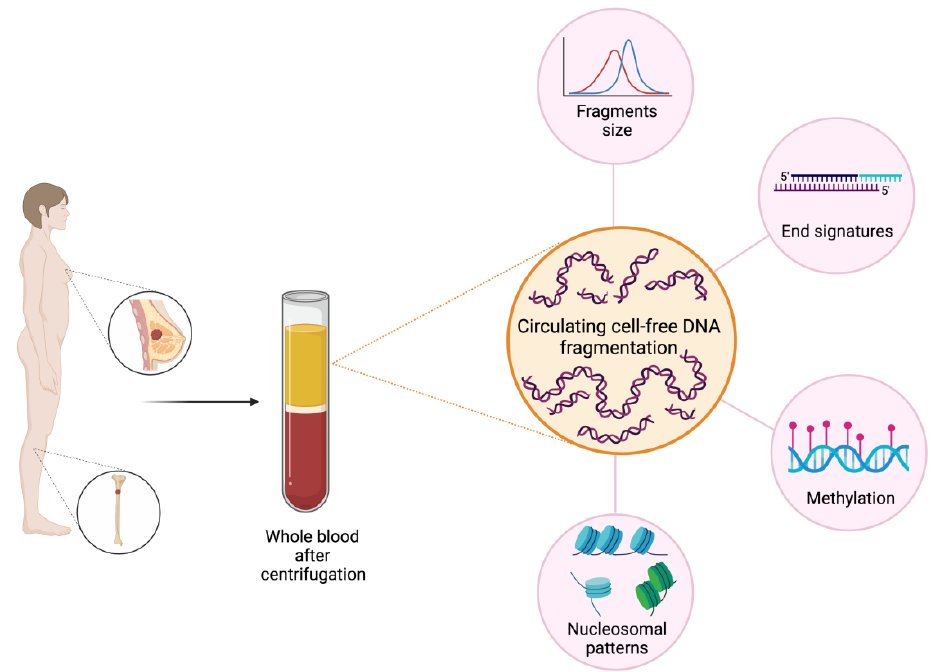
Figure 1. Fragmentomics features in BC. The study of fragmentomics in BC includes various aspects such as the evaluation of fragment size and cfDI, the study of fragment ends with specific motifs included in the sequence of the fragment and the nucleosome footprints or position. The potentiality of fragmentomics covers a wide range of applications in BC, from the early stage with a role in cancer detection and evaluation of the minimal residual disease, to advanced stages, where it may be useful in the prediction of treatment efficacy or resistance and the evaluation of response to therapies. Created with BioRender.com.